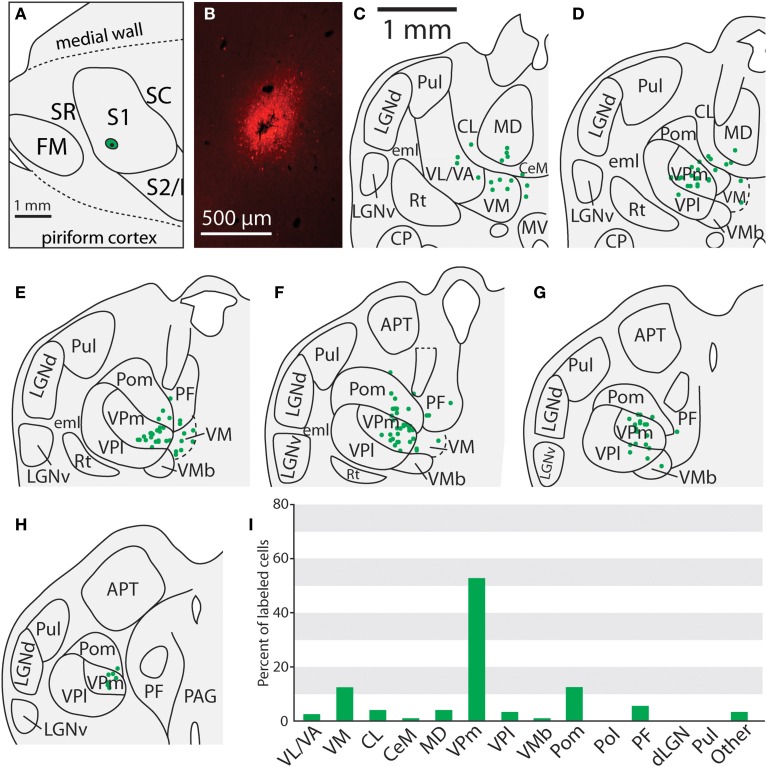
Projections to the face representation in case 13-126. (A) The location of an FR injection site in the lateral portion of S1 in the representation of the face. (B) Fluorescent image of the FR injection site and surrounding halo. (C–H) Progression of the thalamic sections with labeled neurons, showing labeled neurons largely restricted to VPm, Pom and VM. (H) Percent of labeled thalamic neurons in this experiment. (I) Percent of labeled neurons originating from various thalamic nuclei. Conventions as in previous figures.